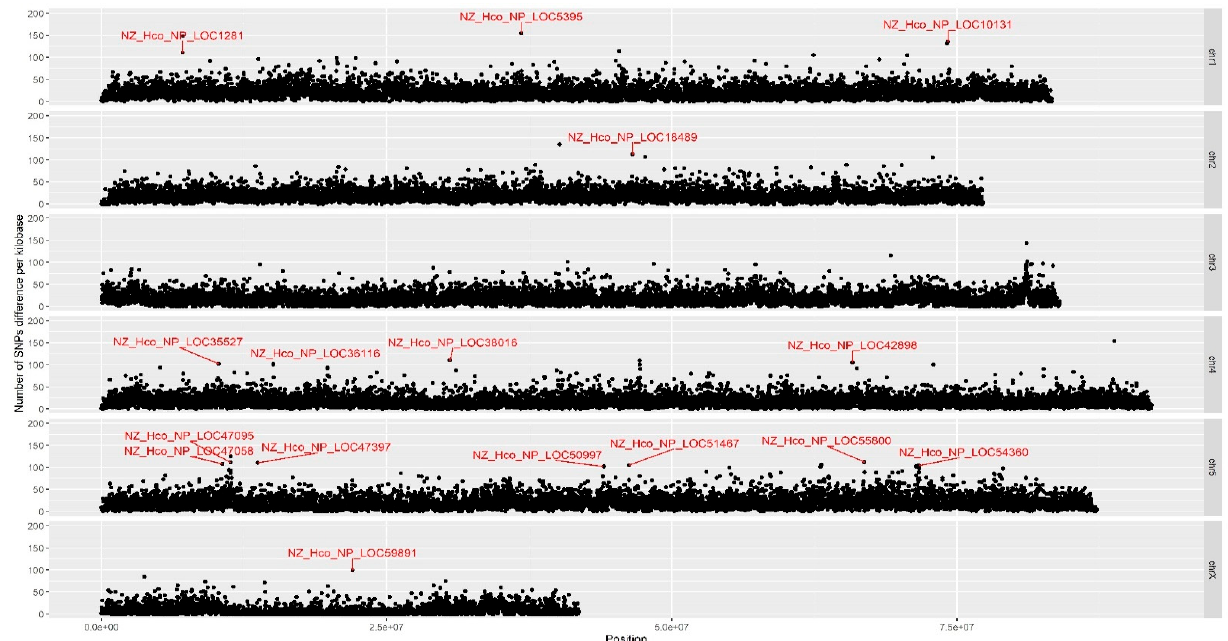
Figure 2. Chromosome-wide distribution of significant SNPs identified with different calls between the vaccine-treated and non-treated groups. Chromosomes (chr) 1–5 and X are shown from top to bottom with locus tags displayed where significant SNPs are associated with annotated genes over a 10 Kbp window. Microbial community profiling using next-generation sequencing of the 16S rRNA gene (V3–V4 region) results showed small but clear changes to the bacterial communities between the control and vaccine treatment groups at both the genus and species levels (Figure 3). Overall, there was no detectable contamination in the majority of the H. contortus microbiome samples, and the vaccine treatment had small but significant impacts on the composition of the parasite microbiota. Exceptions to these findings include samples 3 and 19, which were removed from downstream analysis as their profiles were completely different from all other samples (Figure S1). The observed bacterial contamination of the DNA samples was likely due to environmental contaminants, which possibly calls for improvements to the current and standard sterilization methods used